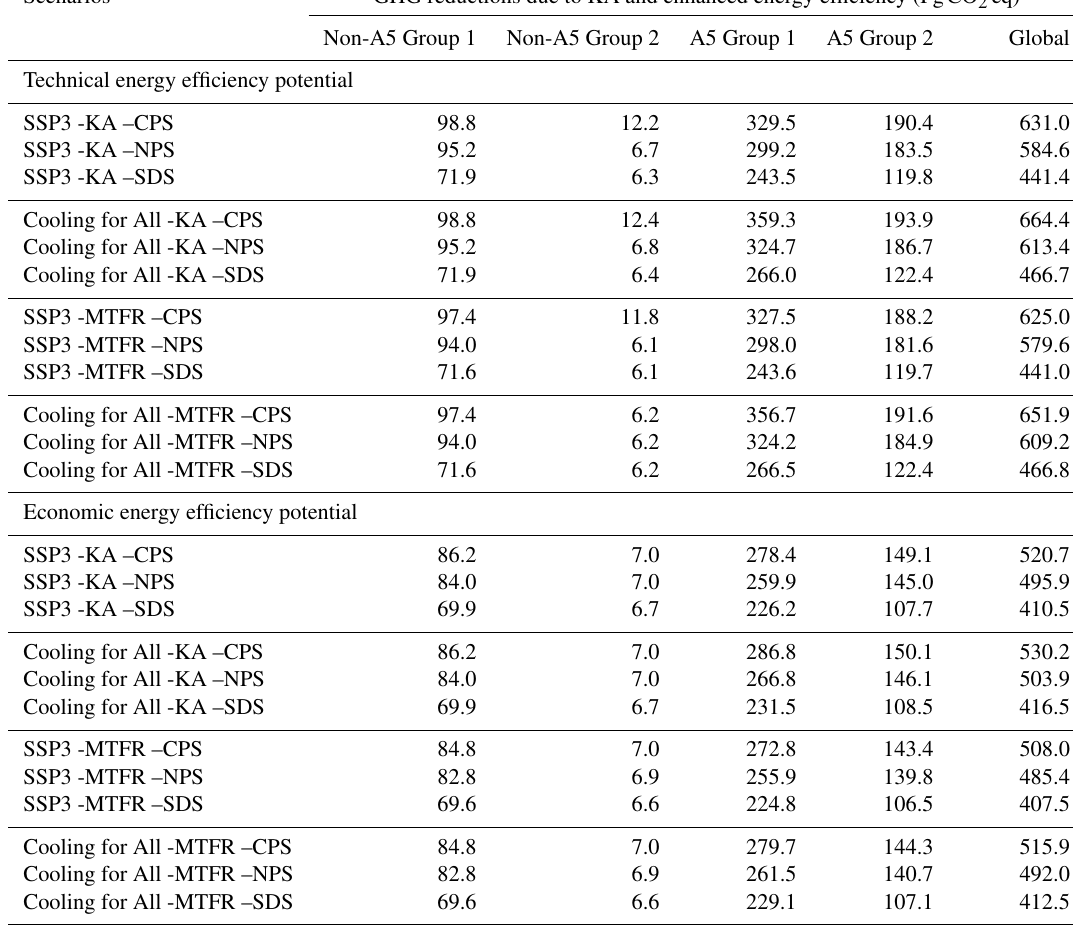
Table 5. Cumulative reductions in greenhouse gas emissions 2018–2100 due to electricity savings induced by HFC phase-down when assuming technical and economic energy efficiency improvement potentials, by Kigali Amendment party